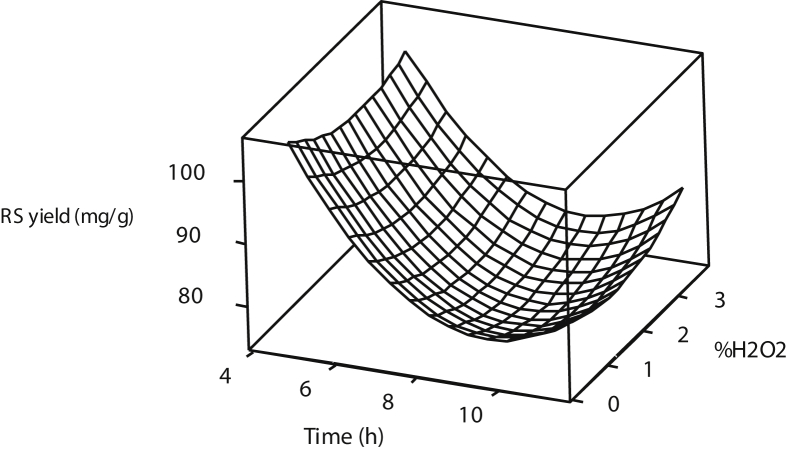
Surface plot for reducing sugar yield against %H2O2 and Time.